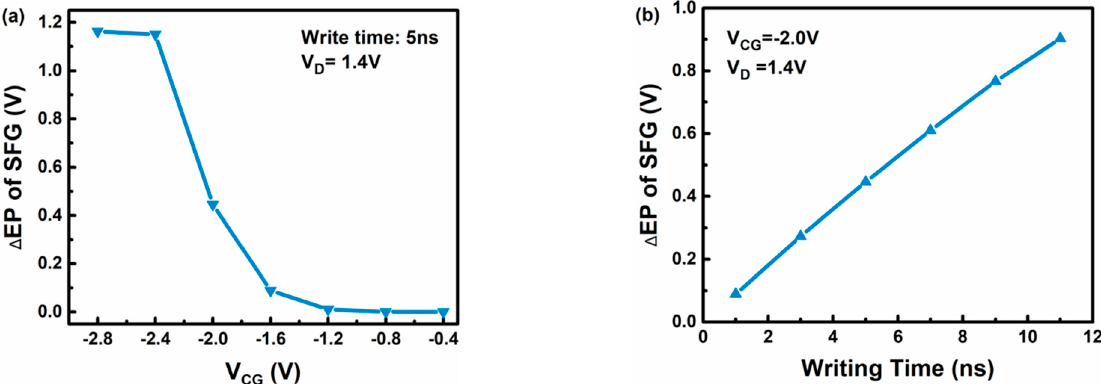
Figure 3. ( a ) The dependence of ∆ EP of the semi-floating gate (SFG) on V CG during the write-1 operation; ( b ) The relation between the ∆ EP of the SFG and the writing time for write-1 operation. V CG is − 1.4 V and V D is 2 V.